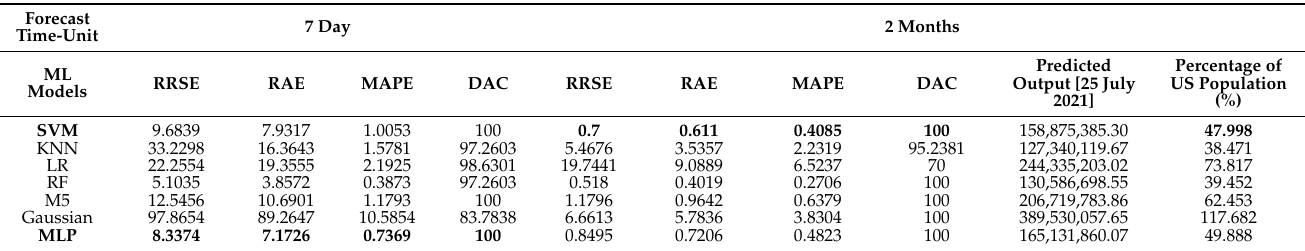
Table 7. Prediction accuracy and error for different machine learning models to forecast fully vaccinated population in the USA.